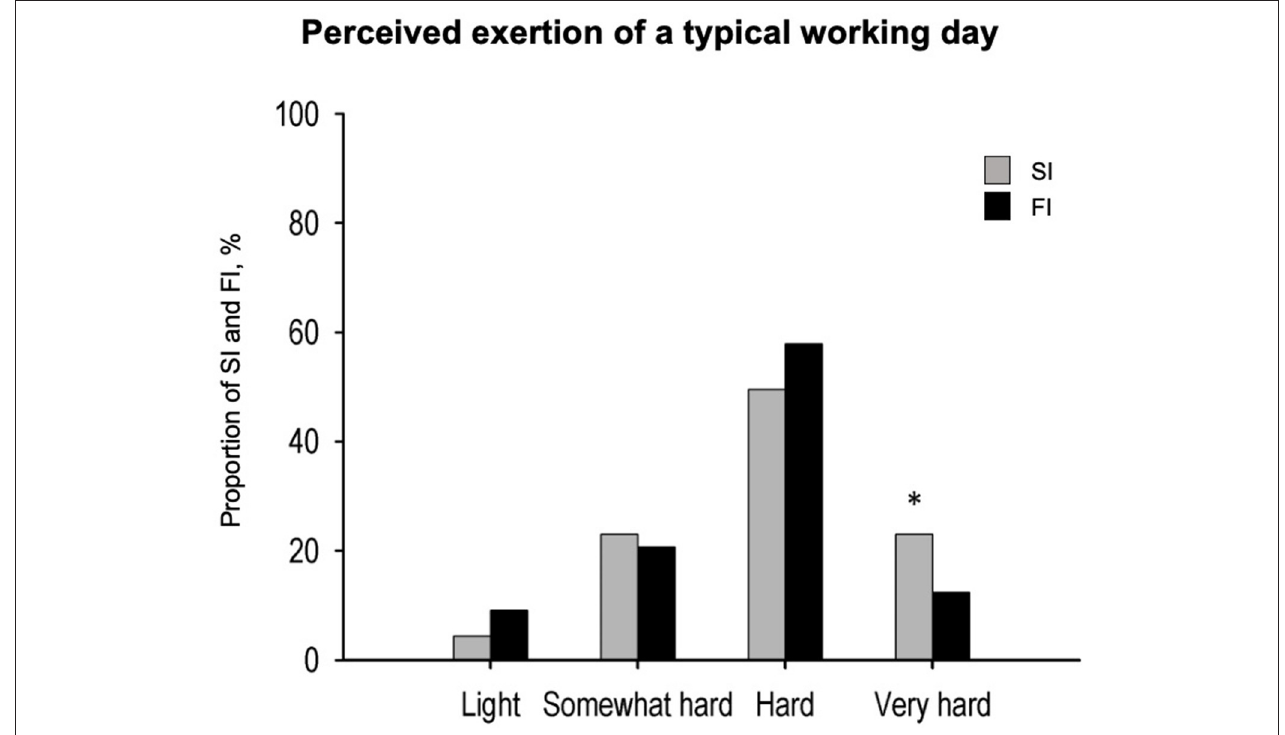
FIGURE 3 | Perceived exertion during a typical lesson (SI, swimming instructors, n = 42; FI, fitness instructors, n = 57). * p < 0.05 between